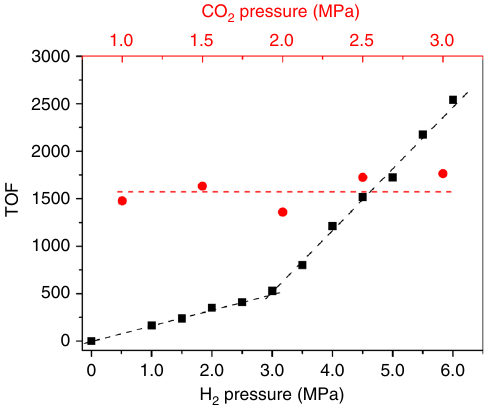
Fig. 3 H 2 (black square) and CO 2 (red circle) pressure-dependent initial reaction rates. Reaction conditions: 5 mg Au/SiO 2 -Schiff catalyst, 10 mL reagent, 10 mmol NEt 3 , 600 rpm, H 2 O/CH 3 OH (20:80 vol/vol). The solution was pressurized at room temperature with CO 2 and completed with H 2 to the desired pressure. The system was heated at 90 °C and stirred until a desired formate concentration was reached (0.5 – 3 h). The initial TOF is calculated by the Supplementary Equation